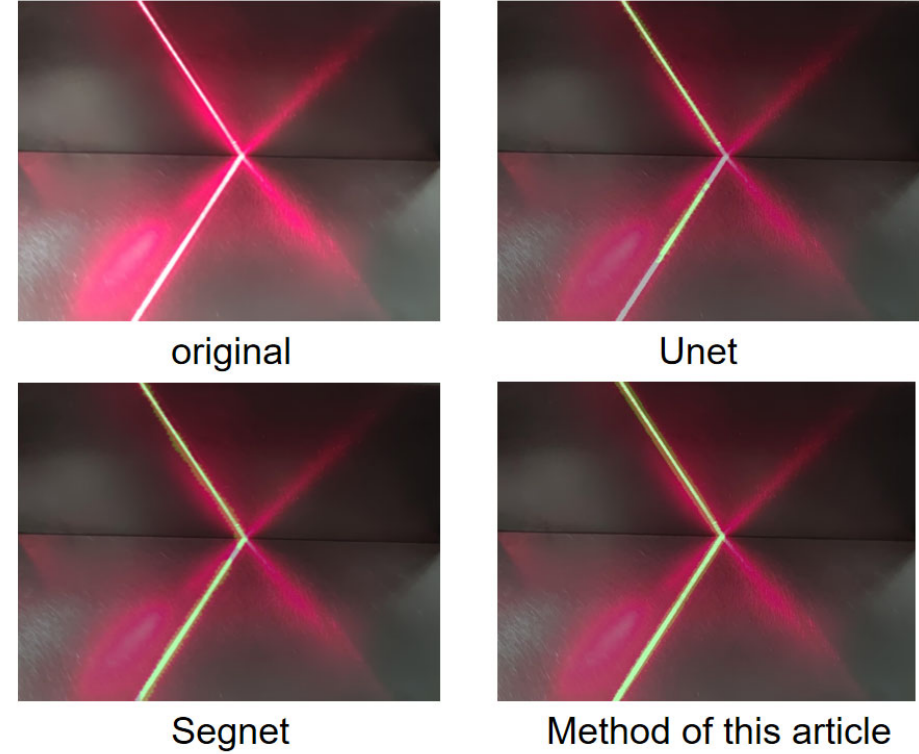
Figure 6. The image processing results of the different models. Table 2. Comparison of the results.